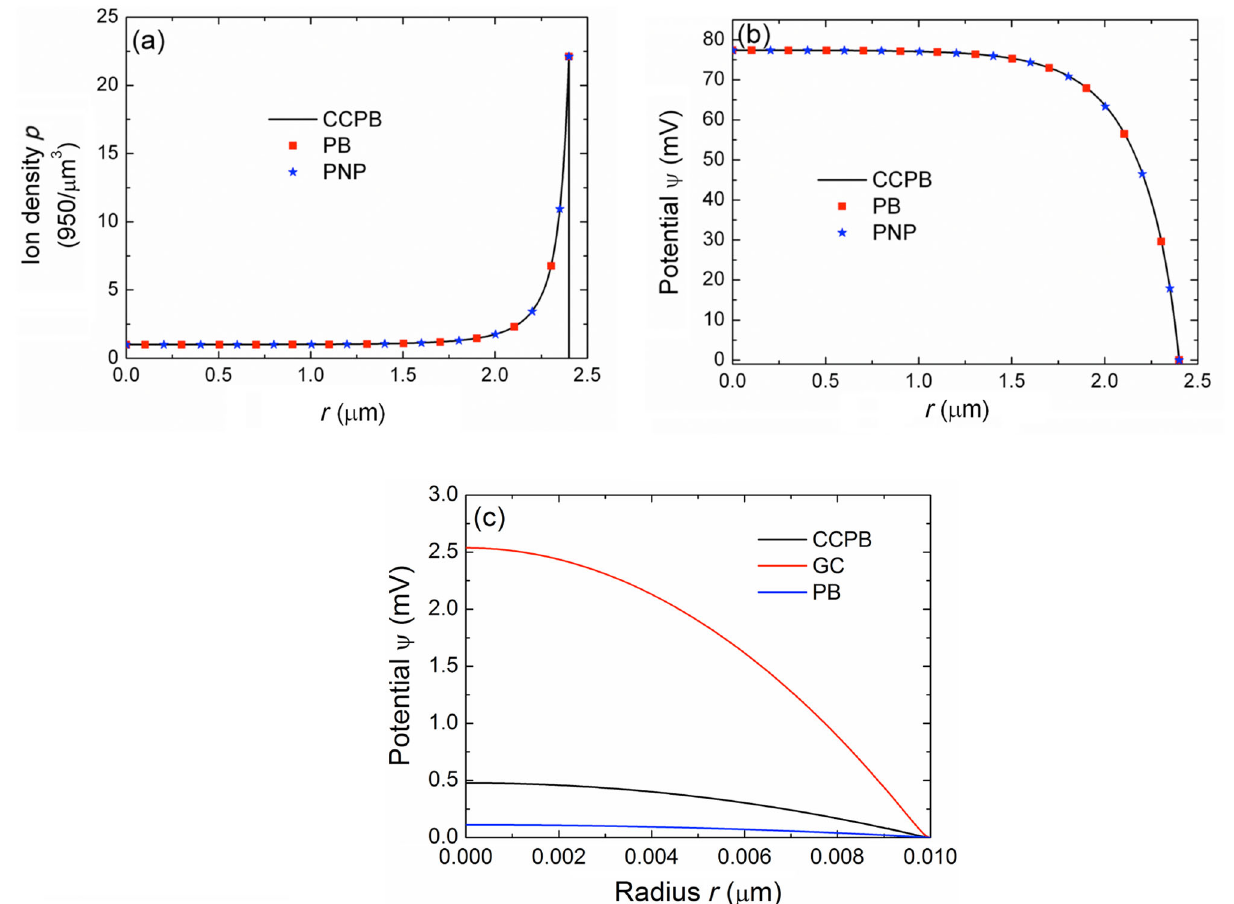
FIG. 3. (a) The distribution of the positive ions for a ¼ 2 . 4 μ m. Almost exact agreement is seen between the predictions of the PB and CCPB equations. The static limit of the PNP equations is also plotted, which (not surprisingly) agrees exactly with the CCPB. Not shown are the predictions of the Gouy-Chapman model (CC), which is exactly the same as that for the PB (CP) equation, with the Neumann boundary condition that corresponds to a surface charge density of s ¼ 2058 = μ m 2 . At a ¼ 2 . 4 μ m, the actual value of s ¼ 2016 . 8 = μ m 2 . (b) The potential profile for the Debye screening layer for a ¼ 2 . 4 μ m. Again, almost exact agreement is seen between the three cases. (c) The potential profile for the PB (blue line) and CCPB (black line) equations, plus the Gouy-Chapman (red line) model when a ¼ 10 nm. In contrast to (a) and (b), significant differences are seen for the predicted potential profiles. For the Gouy-Chapman model (CC), we use the same value of the surface charge density as that for the larger a , i.e., 2058 = μ m 2 . For the PB (CP) case, the value of ζ ¼ − 76 . 55 mV has been used as the boundary condition. In the CCPB case, the use of either − μ ¼ − 114 . 3 mV or σ ¼ s ¼ 450 = μ m 2 would yield the result shown by the black curve in (c). For ease of comparison, in all cases the potential value at the boundary is shifted to